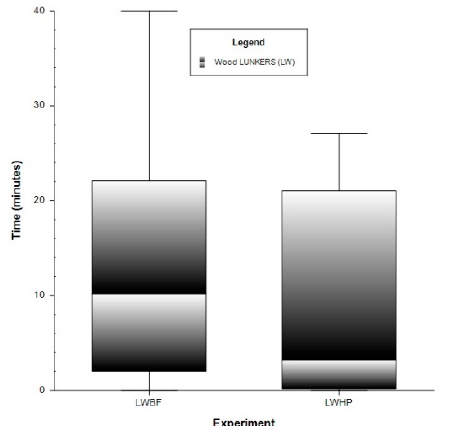
Figure 4. Boxplots of the time (min) that L. bocagei individuals have continuously spent inside the wood L-structure.